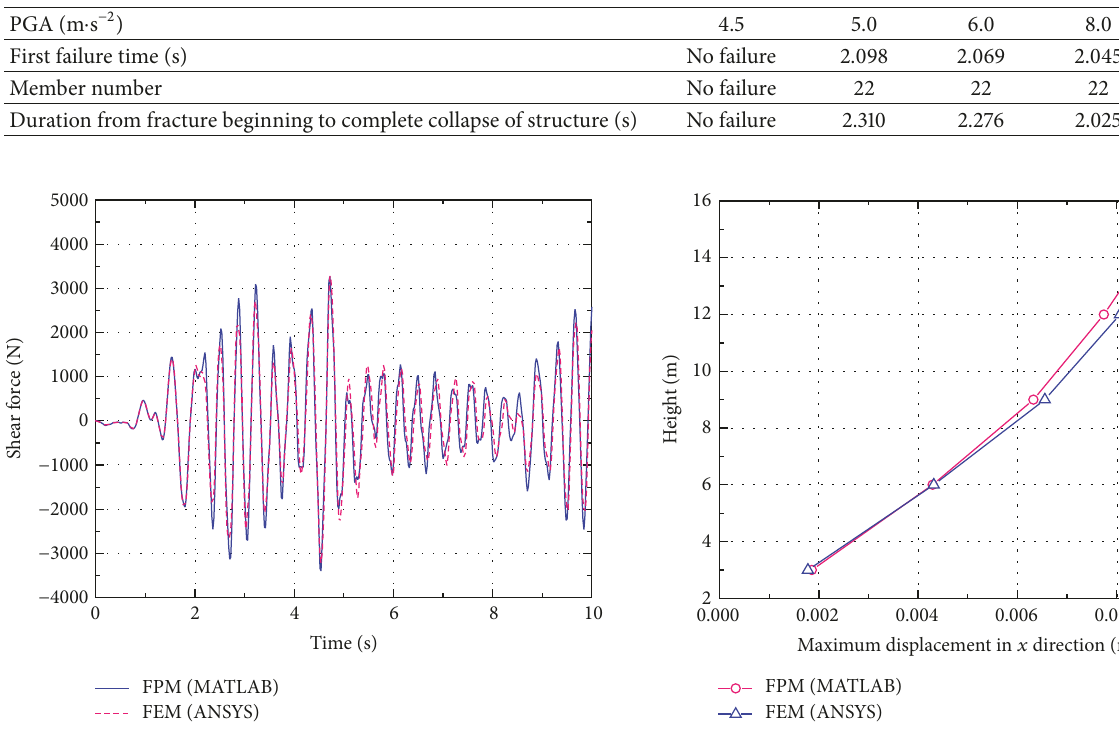
Figure 29: Z-direction shear time history curve for the left end of element 22.